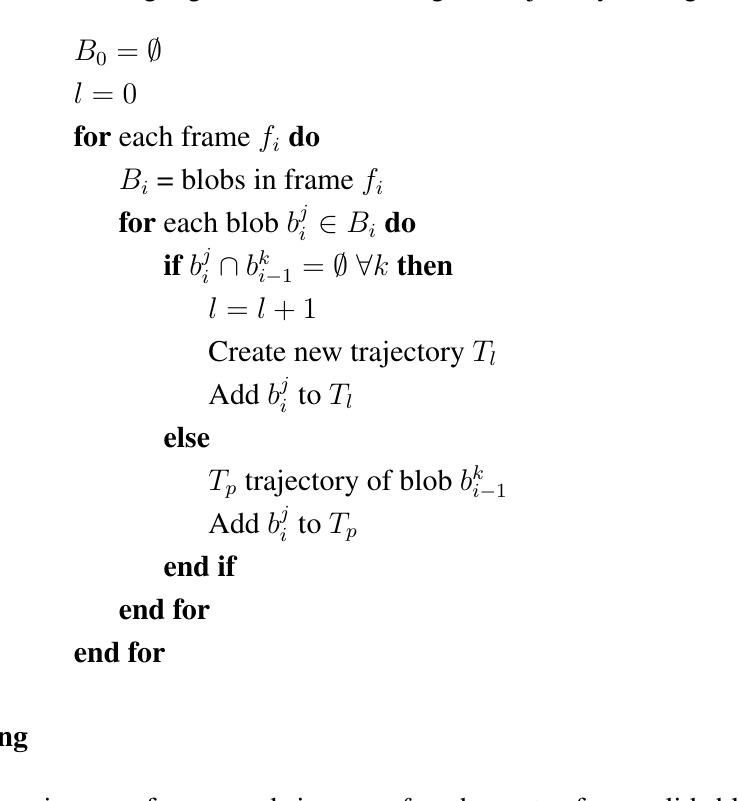
Figure 4. Tracking algorithm summarizing the trajectory